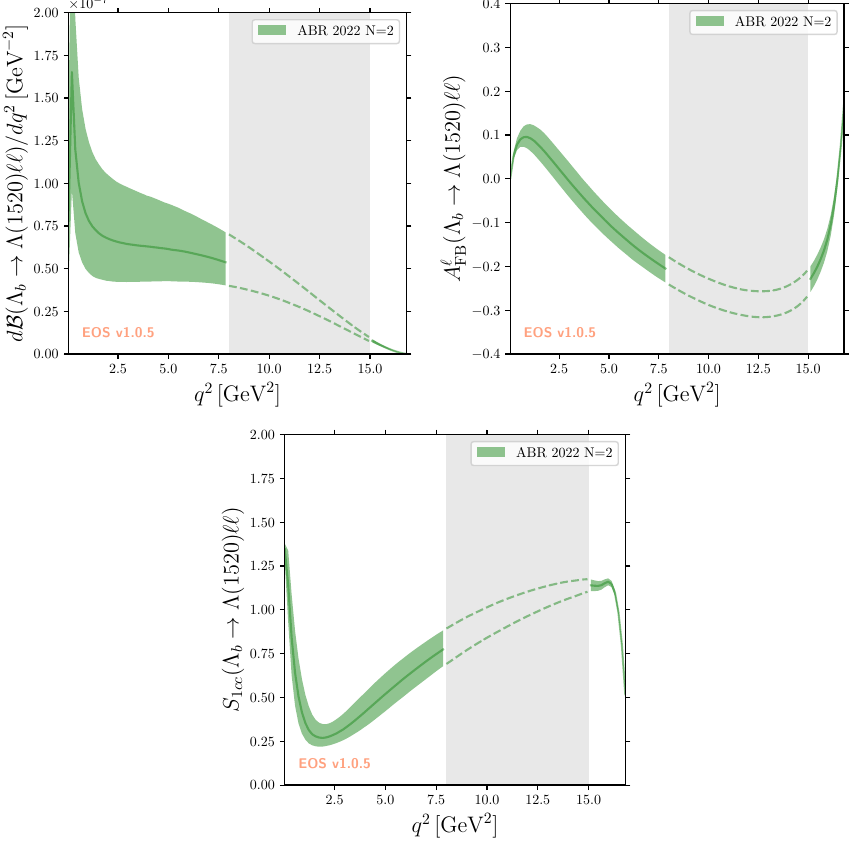
Figure 4 . Plots of the differential branching fraction (upper left plot), differential forward-backwards lepton asymmetry (upper right plot) and differential S 1 cc (lower plot). The green bands are the 68% C.L. region, and the full line is the median of the distribution in the nominal fit. We use dashed lines in the vetoed resonant